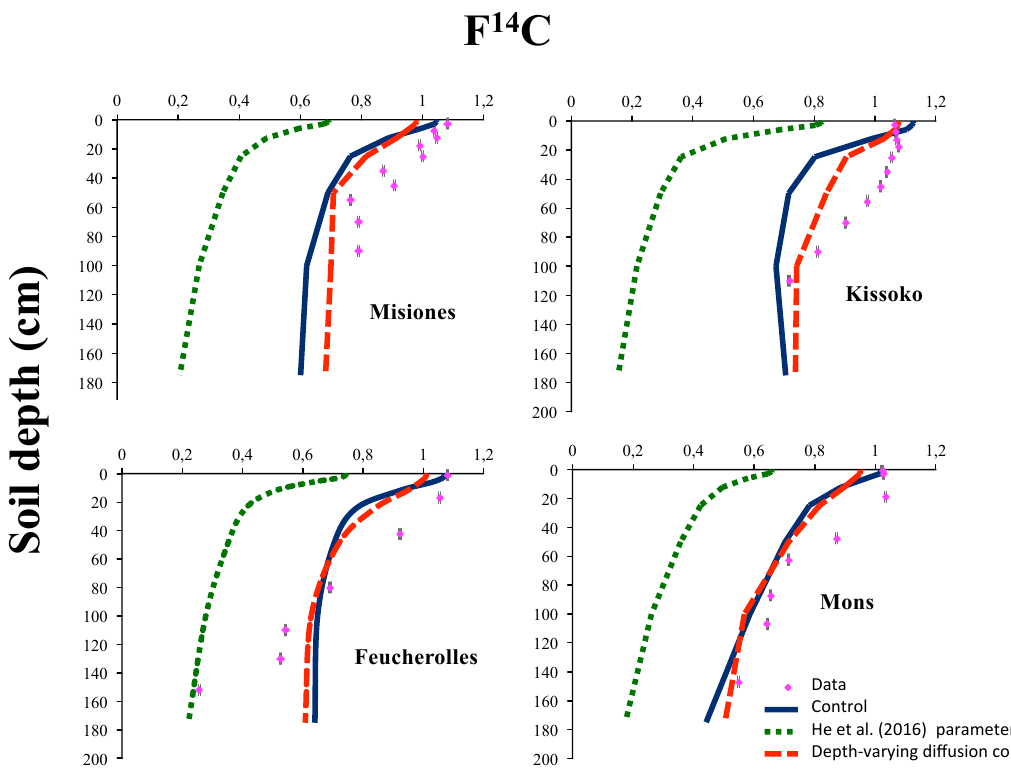
Figure 5. Modern fraction F 14 C according to depth for the four sites. The results of the initial version of the model ORCHIDEE-SOM- 14 C (Control), those from the version including the modification according to He et al. (2016) (He et al., 2016, parameterization) and diffusion varying according to depth (Depth-varying diffusion constant) are shown. Table 4. The correlation coefficient ( r ) between model outputs and measurements and the mean values (provided by the model and the measurements) over the profile according to F 14 C for the four sites. The results of the initial version of the model ORCHIDEE-SOM- 14 C (Control), those from the version including the modification according to (He et al., 2016) (He et al., 2016, parameterization) and diffusion varying according to depth (Depth-varying diffusion constant) are